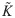
Distorting effect of intensity rescaling on K˜ values.
Panel A: Left—Sample images from each of the five constructs described in Fig 10. Right—Same images after intensity normalization to occupy the full 8-bit dynamic range. Panel B: K˜ values for the images in Panel A at three different radii (2, 4, and 6 pixels). Note the distorting effect of intensity normalization not only on the K˜ values, but also on the relative ranking of images.